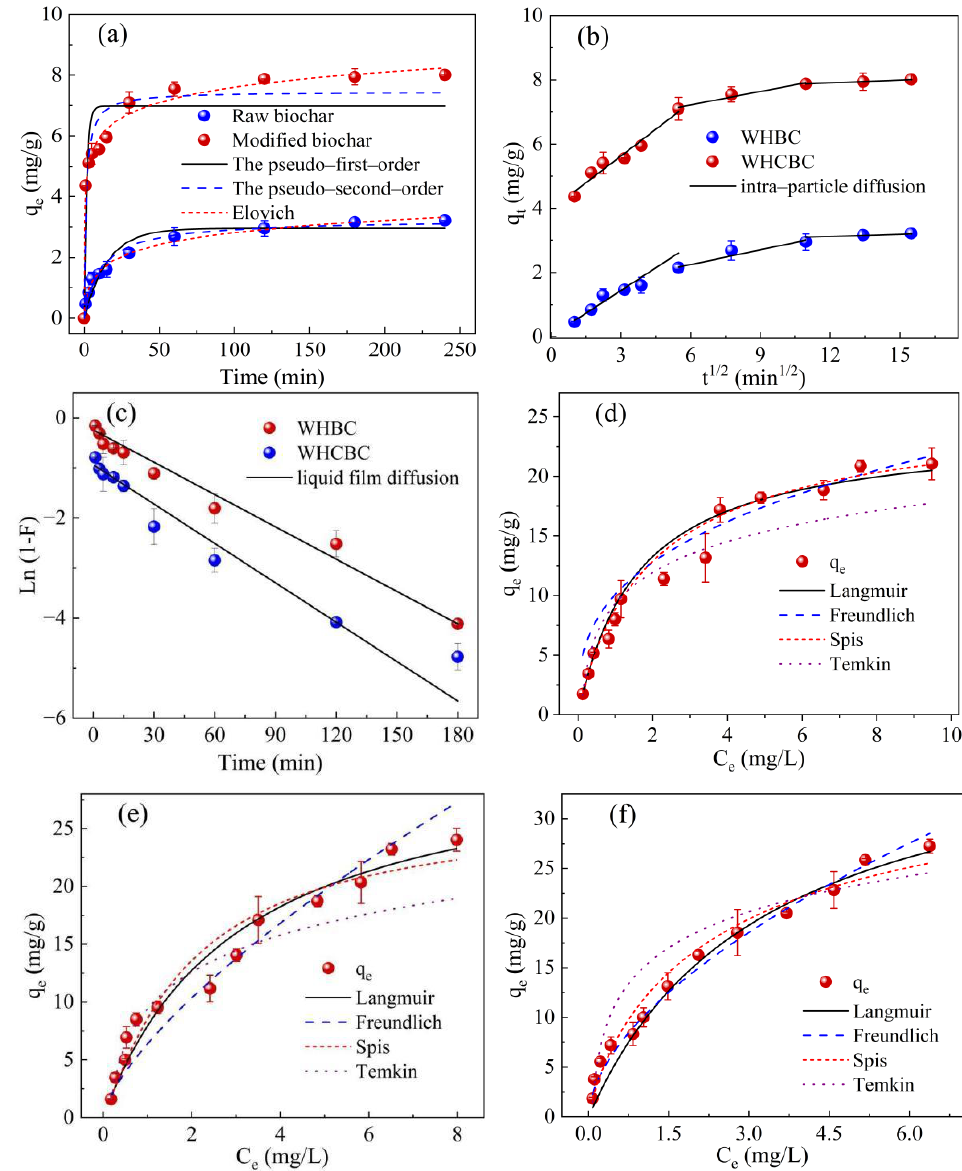
Figure 3. The adsorption kinetics and isotherms of TE on the two kinds of biochar: ( a – c ) adsorption kinetics of WHBC and WHCBC at 5 mg/L TE in water; and ( d – f ) are the adsorption isotherms of WHCBC at temperatures of 25 °C, 35 °C, and 45 °C, respectively.